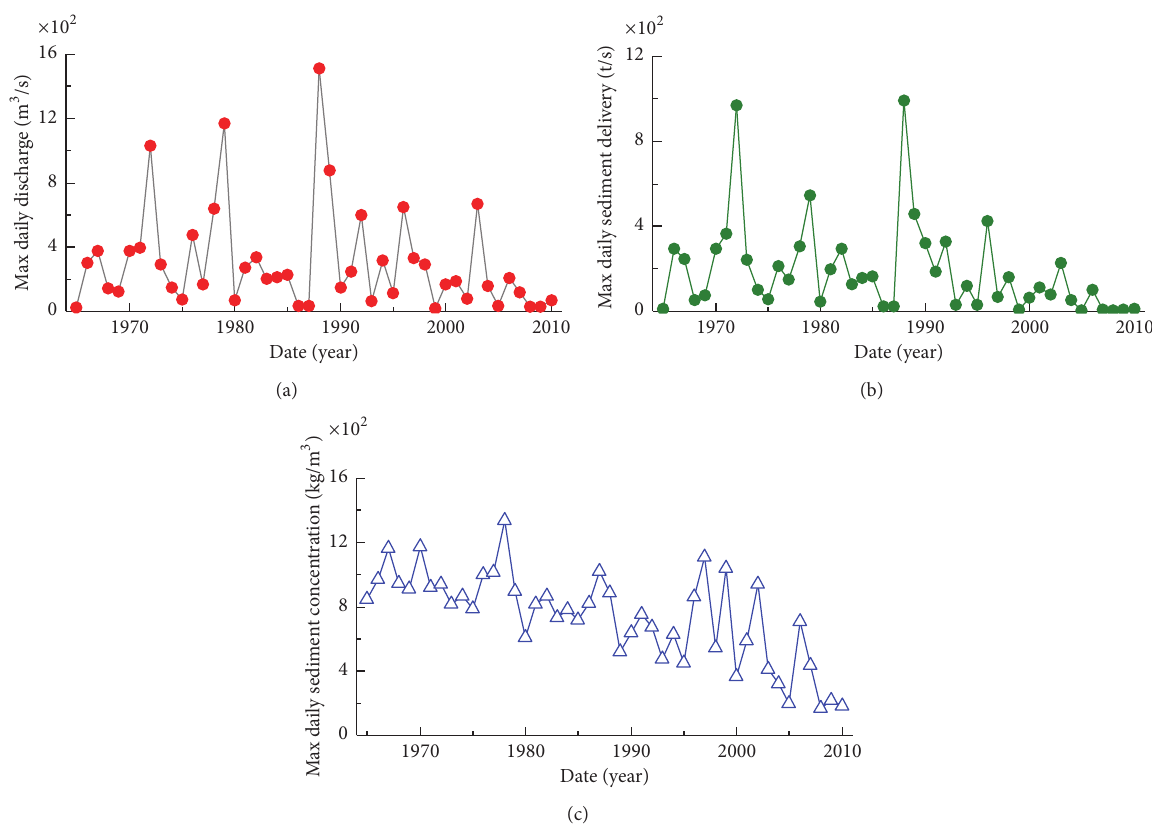
Figure 6: Maximum daily runoff (a), sediment delivery (b), and sediment concentration (c) at Huangfu station from 1965 to 2010.